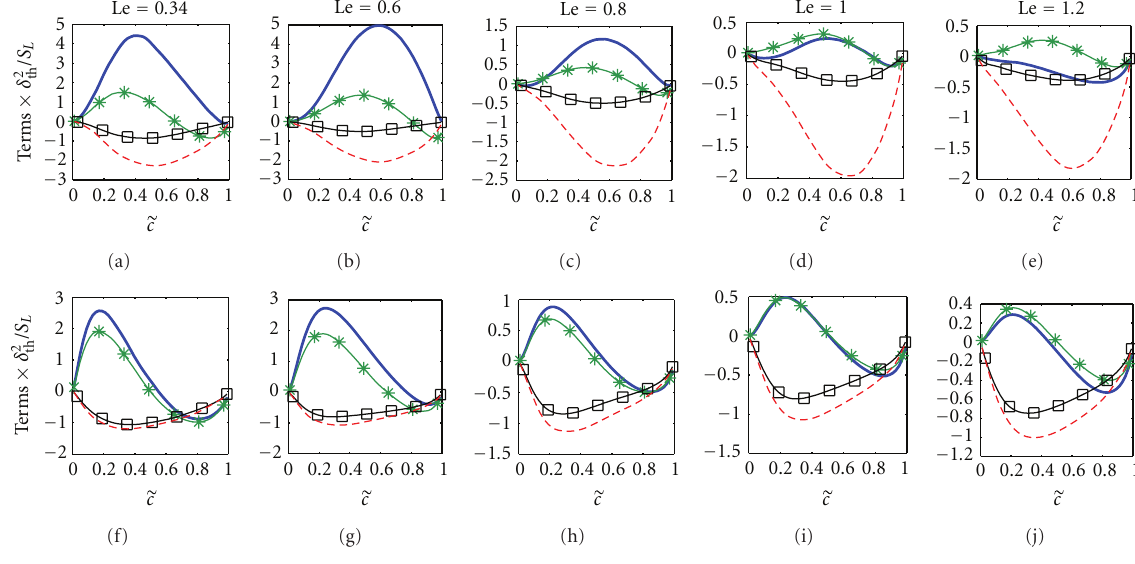
(cid:2) N Figure 3: Variation of (( S r + S n ) ∇ · ) s Σ gen (solid line), − 4( Dκ 2 m ) s Σ gen (dashed line), C sg1 (asterisk line), and C sg2 (squared line) conditionally averaged in bins of (cid:2) c across the flame brush for Δ = 8 Δ m ≈ 0 . 8 δ th (top row): (a) Le = 0 . 34 (1st column); (b) Le = 0 . 6 (2nd column); (c) Le = 0 . 8 (3rd column); (d) Le = 1 . 0 (4th column); (e) Le = 1 . 2 (5th column) and for filter size Δ = 24 Δ m ≈ 2 . 4 δ th (bottom row): (f) Le = 0 . 34 (1st column); (g) Le = 0 . 6 (2nd column); (h) Le = 0 . 8 (3rd column); (i) Le = 1 . 0 (4th column); (j) Le = 1 . 2 (5th